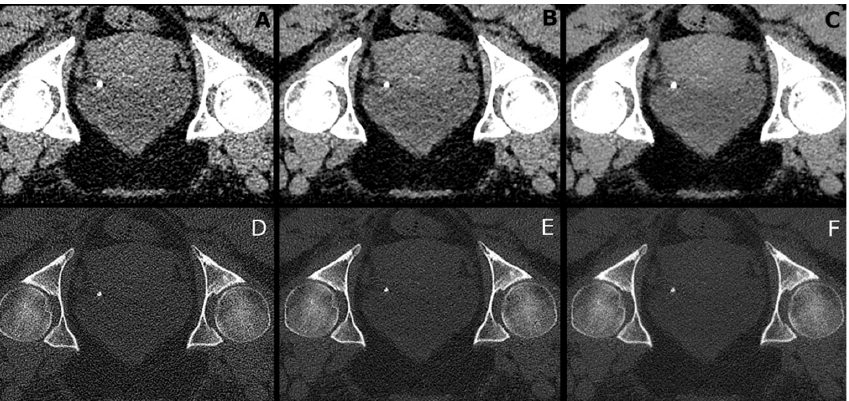
Figure 1. Image example of a patient with an ostial stone on the left side (prone position). ( A – C ): soft kernel, ( D – F ): sharp kernel: left: filtered back-projection, middle: iterative reconstruction, right: PixelShine applied on filtered back-projection. Soft tissue window: width 300 HU, level 40 HU. Bone window: width: 1500 HU, level 450 HU. Table 1. Results of the stone size measurements and statistical analysis. Size measurements of the three evaluated reconstructions were compared (B vs. I, I vs. P, P vs. B). Differences between measurements with shared superscripts were statistically significant. There were no significant differences between sharp kernel reconstructions.